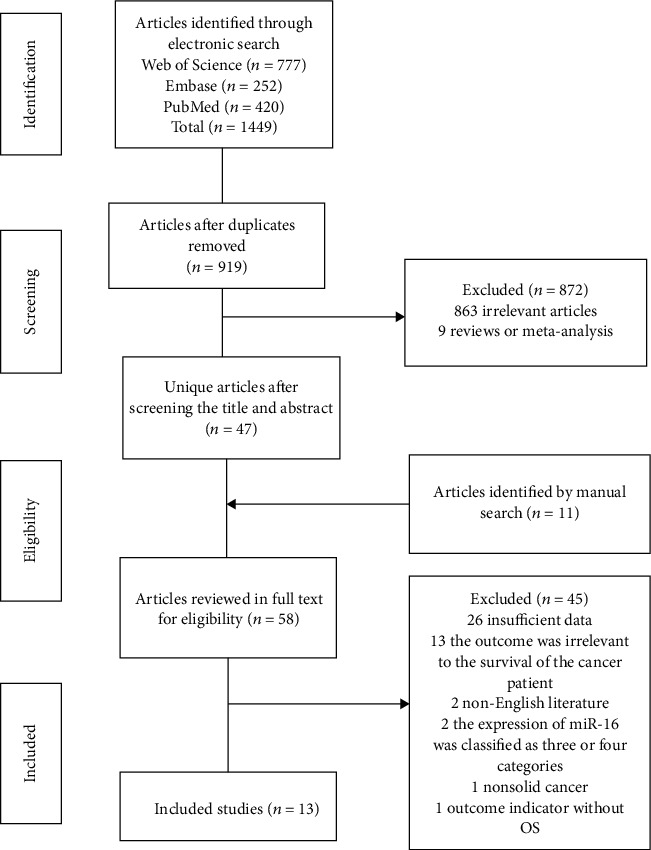
Flowchart of the selected studies (n = 13).